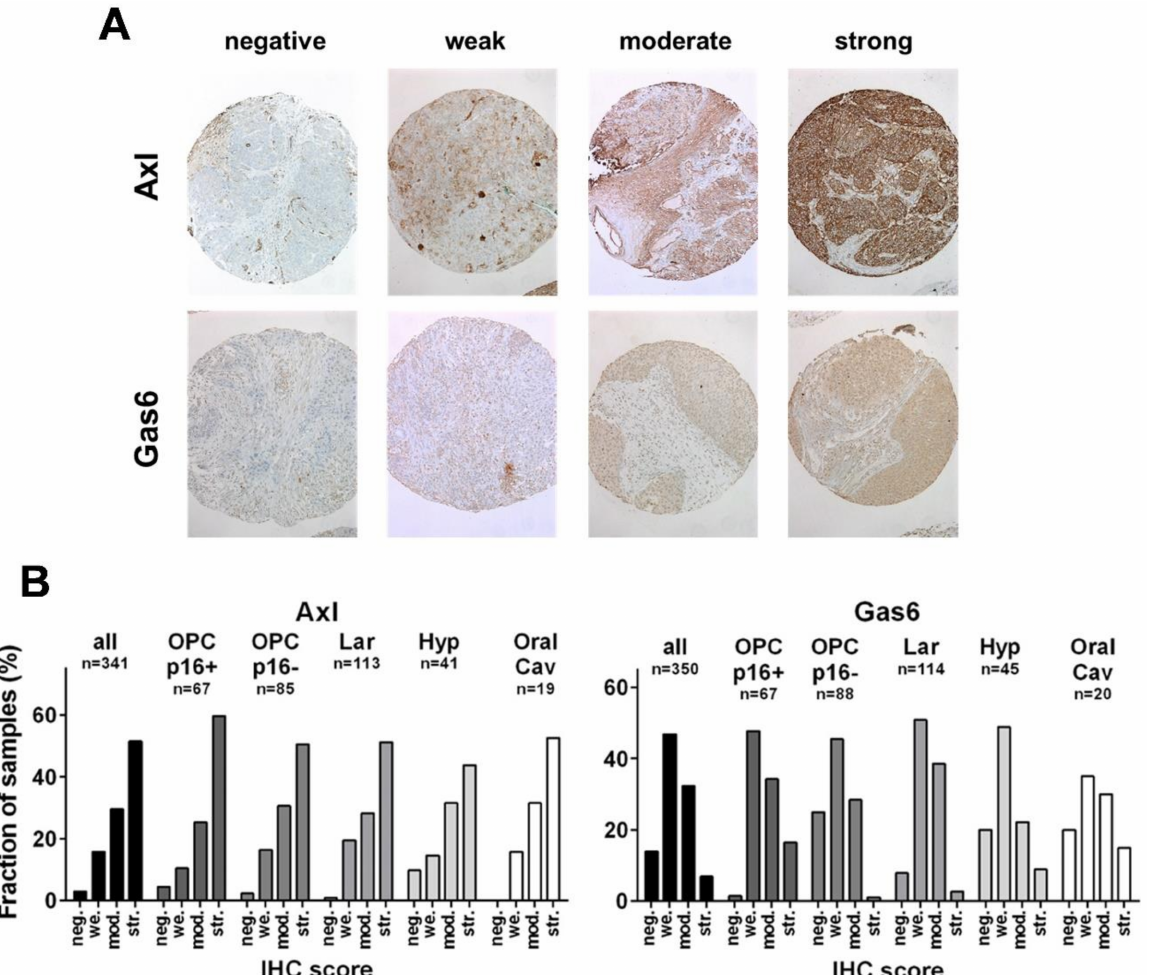
Figure 1. Immunohistochemical staining. ( A ) Representative examples of expression score cate- gories. ( B ) Distribution of expression scores in the whole HNSCC population and specific subtypes. neg.—negative, we.—weak, mod.—moderate, str.—strong,